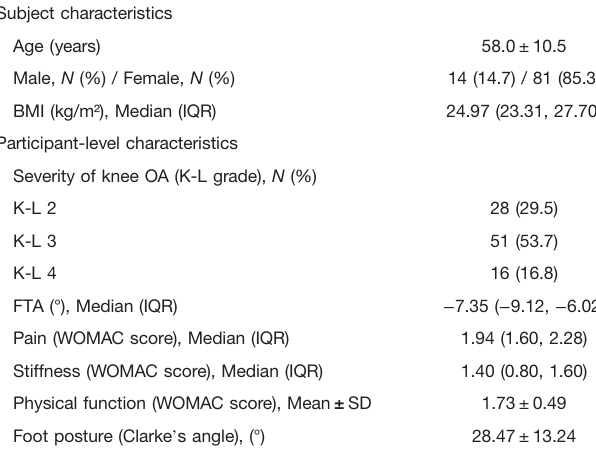
TABLE 1 | Demographic characteristics, participant-level characteristics, and foot posture of the research